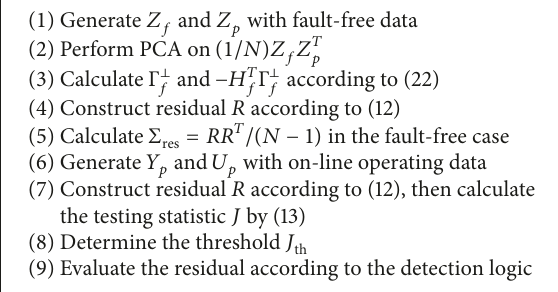
Algorithm 1: SMI-PCA fault